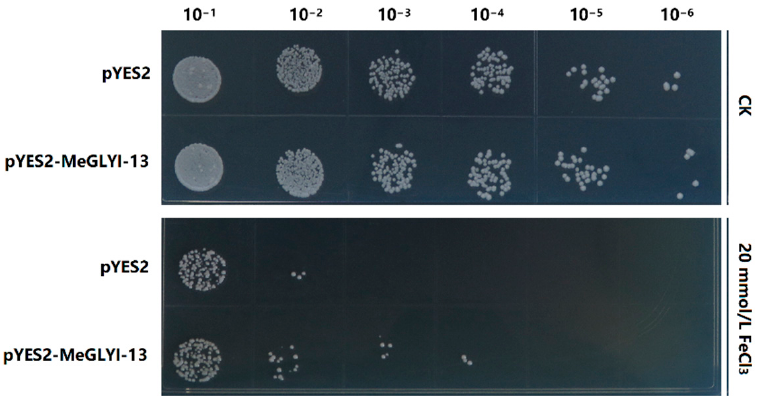
Figure 6. The functional validation of MeGLYI-13 for iron stress resistance using transgenic yeast.